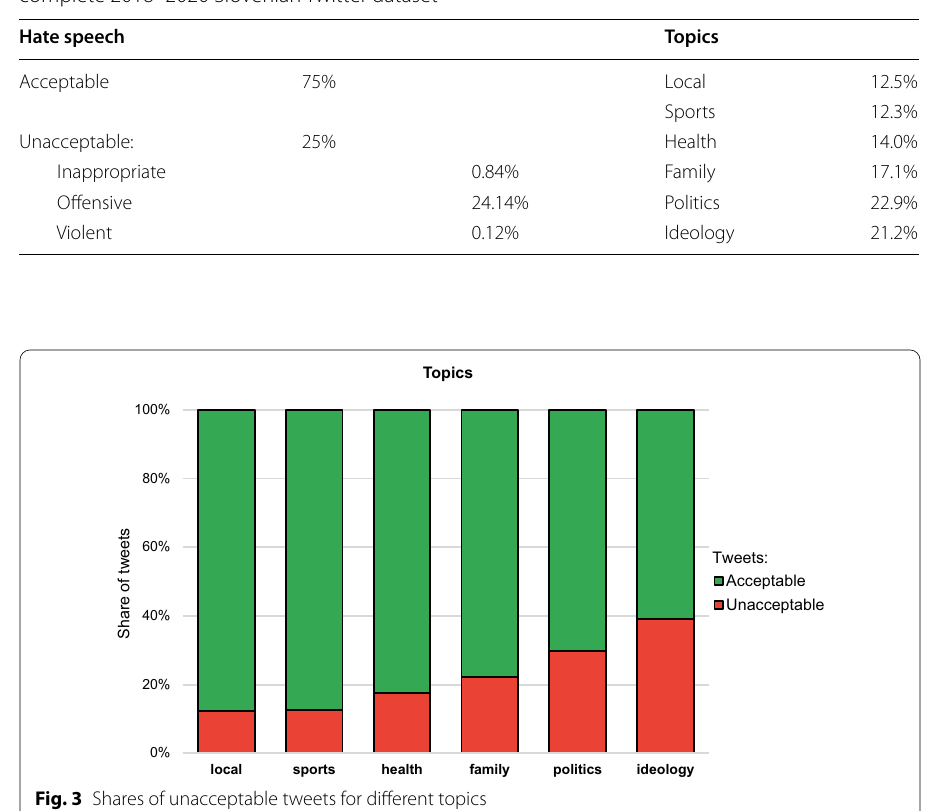
Table 3 Distribution of hate speech classes and subclasses, and detected topics across the complete 2018–2020 Slovenian Twitter dataset